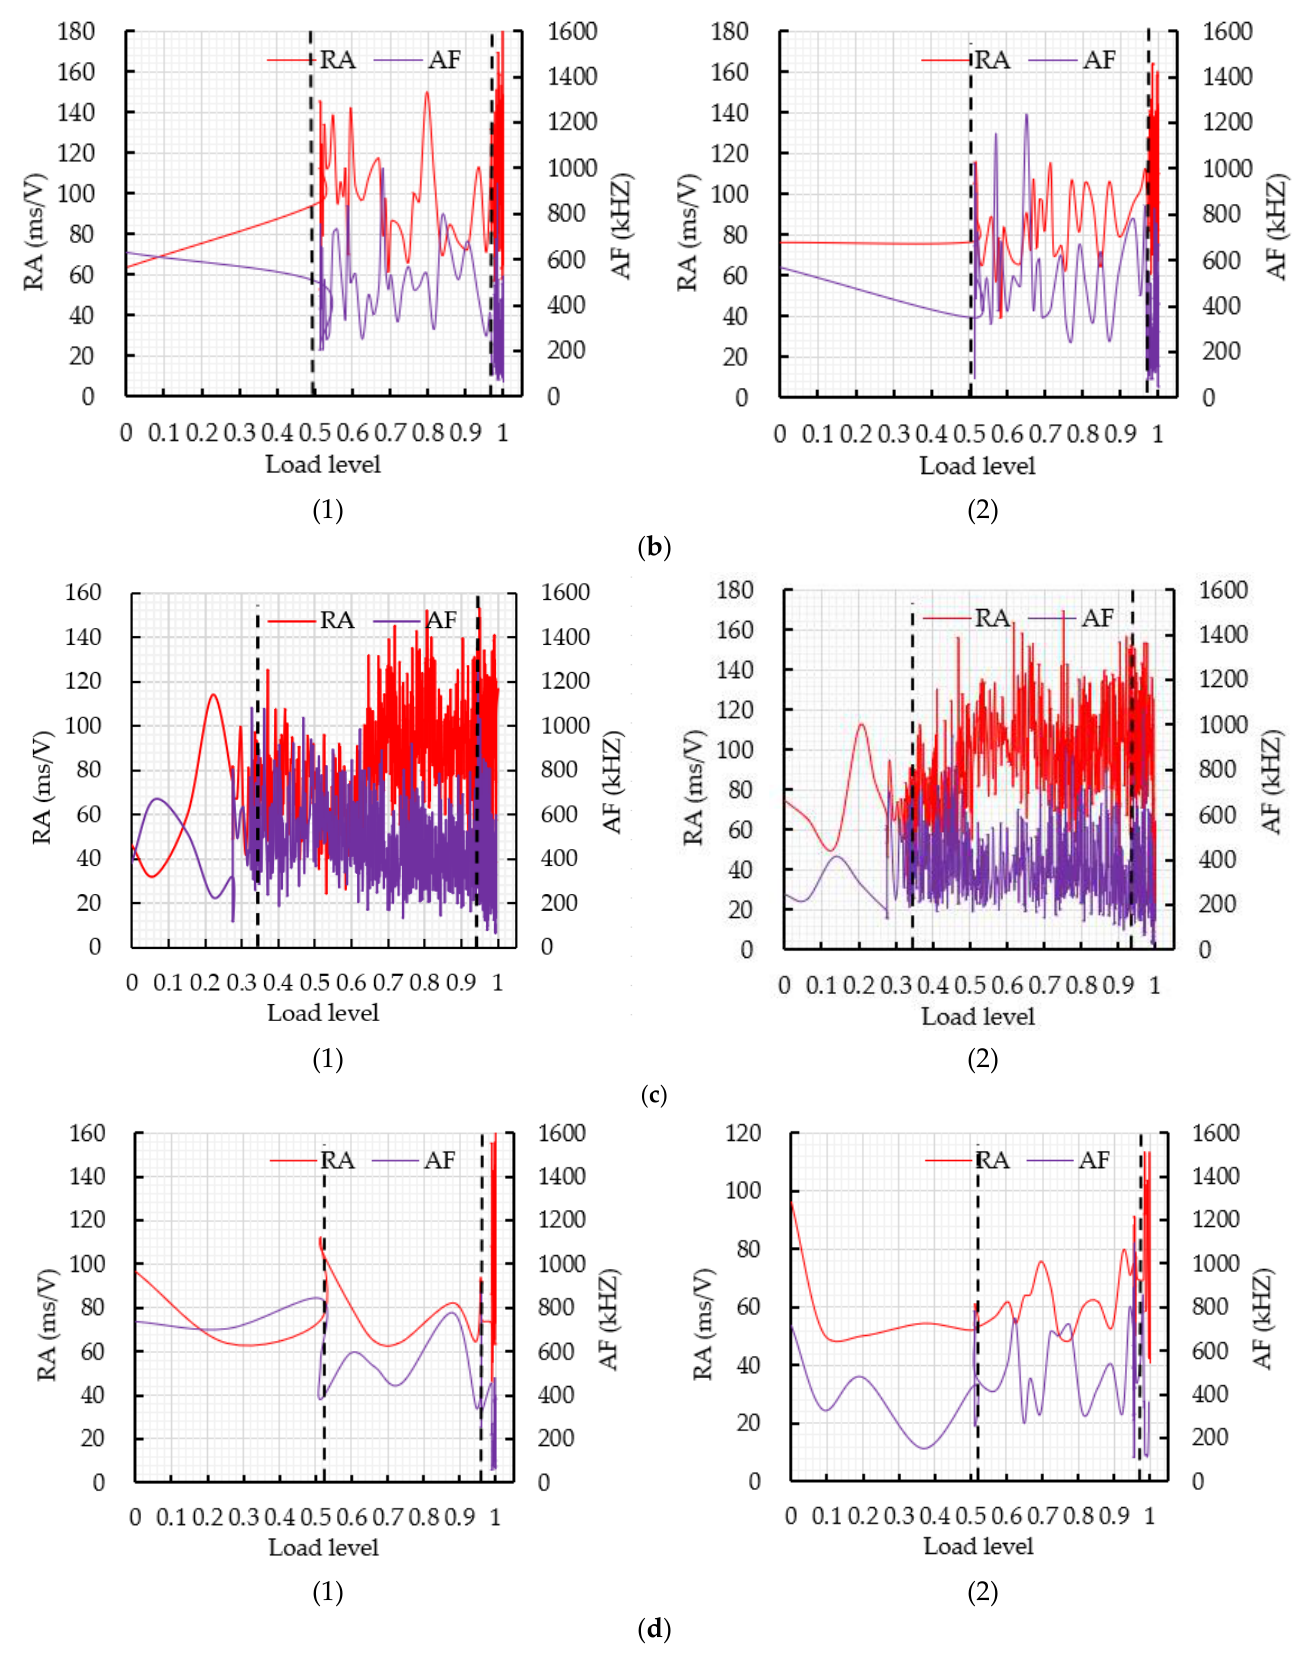
Figure 9. The variation curve of RA and AF: ( a ) RPC; ( b ) SBRPC-1; ( c ) SBRPC-3; ( d ) SBRPC-5. To clearly characterize the transformation of the crack mode of the SBRPC during the fracture process, a parameter RA and AF ratio (RF) is defined in this paper. The calculation formula of RF is as follows: